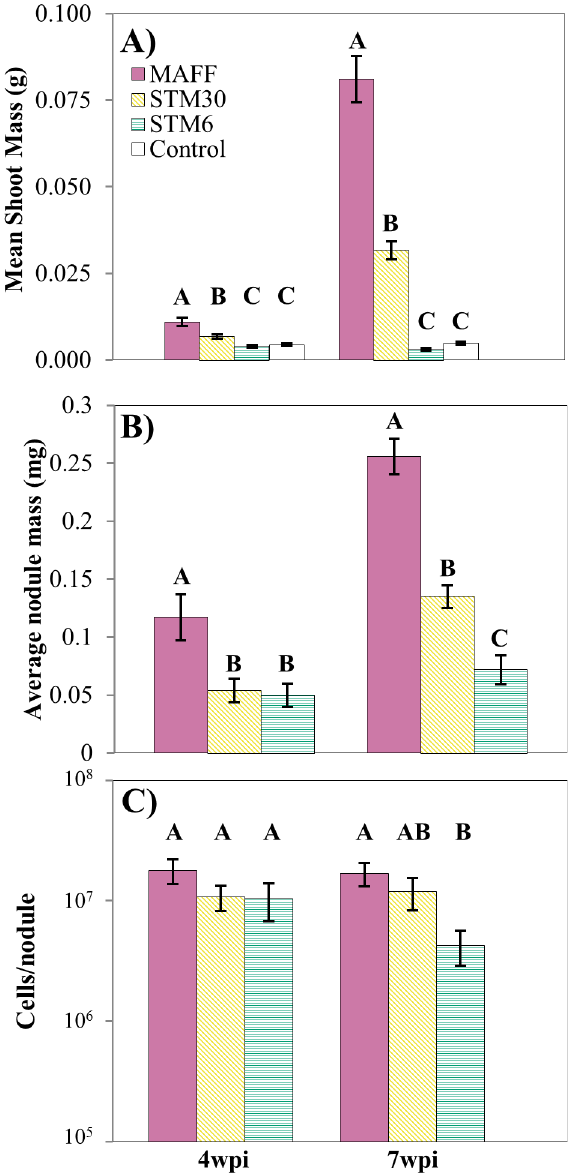
Fig 2. Traits of host and symbiont in greenhouse experiment. L . japonicus hosts were grown in sterilized quartzite sand supplemented with N-free Jensen’sfertilizer. Hosts were singly inoculatedor co-inoculated with the near-isogenic M . loti strains MAFF, STM30, and STM6 and mean host and symbiont phenotypes were measured. ( A) Symbiont effectiveness measuredas dried shoot biomass. ( B) Host investment in symbionts was measuredas averageindividualbiomass of nodules(dry weight). ( C) Rhizobialfitness was estimated basedon colony forming units (CFUs) from serially diluted extracts of crushed nodules. Error bars indicateone standard error from the mean. Data points demarked with different letters indicate significant differences betweenstrains at a given wpi (one-wayANOVA, post-hoc Student’s t-test, α = 0.05) We inoculated plants with a 1:1 and 1:9 (MAFF:STM mutant) ratio of genotypes. A frac- tion of the mixtures was plated and each genotype was scored based on colony color (the MAFF strain used expressed red fluorescent protein) to retrospectively determine actual proportions used. The proportion of MAFF in MAFF:STM30 mixtures were close to the